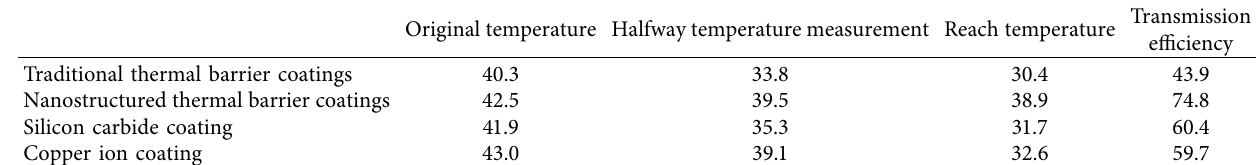
Table 5: Heat transfer efficiency of different coatings.